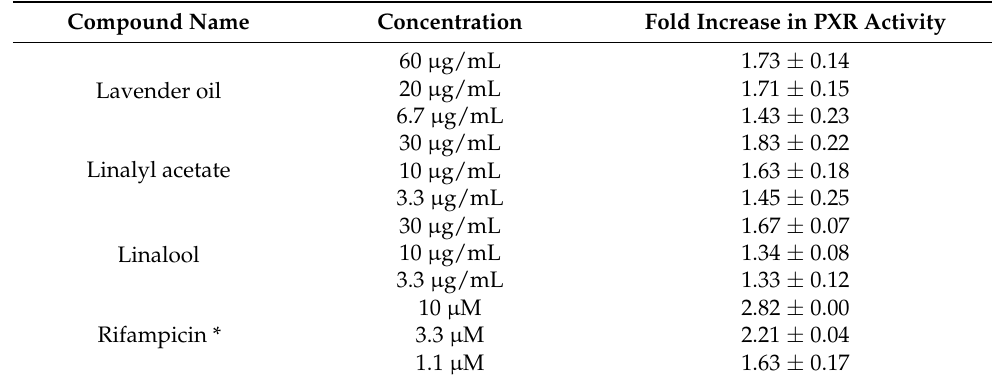
Table 2. Activation of PXR by lavender oil and its constituents in hepatic cell line (HepG2 cells). Data are represented as mean ±